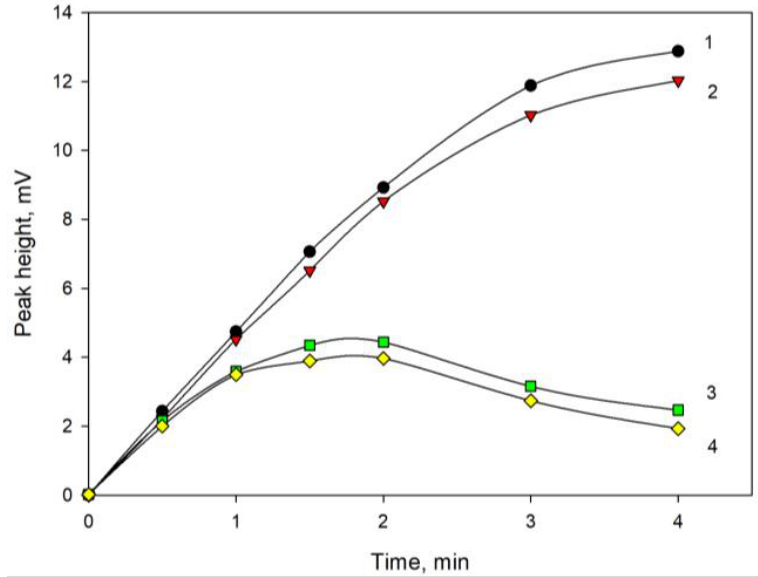
Figure 3. Dependencies of peak heights of n-heptane (2, 4) and n-hexane (1, 3) on the passing time of the gas-extractant (30 mL/min) through aqueous solution in the case of chromatomembrane (1, 2) and dynamic HSA (3, 4).